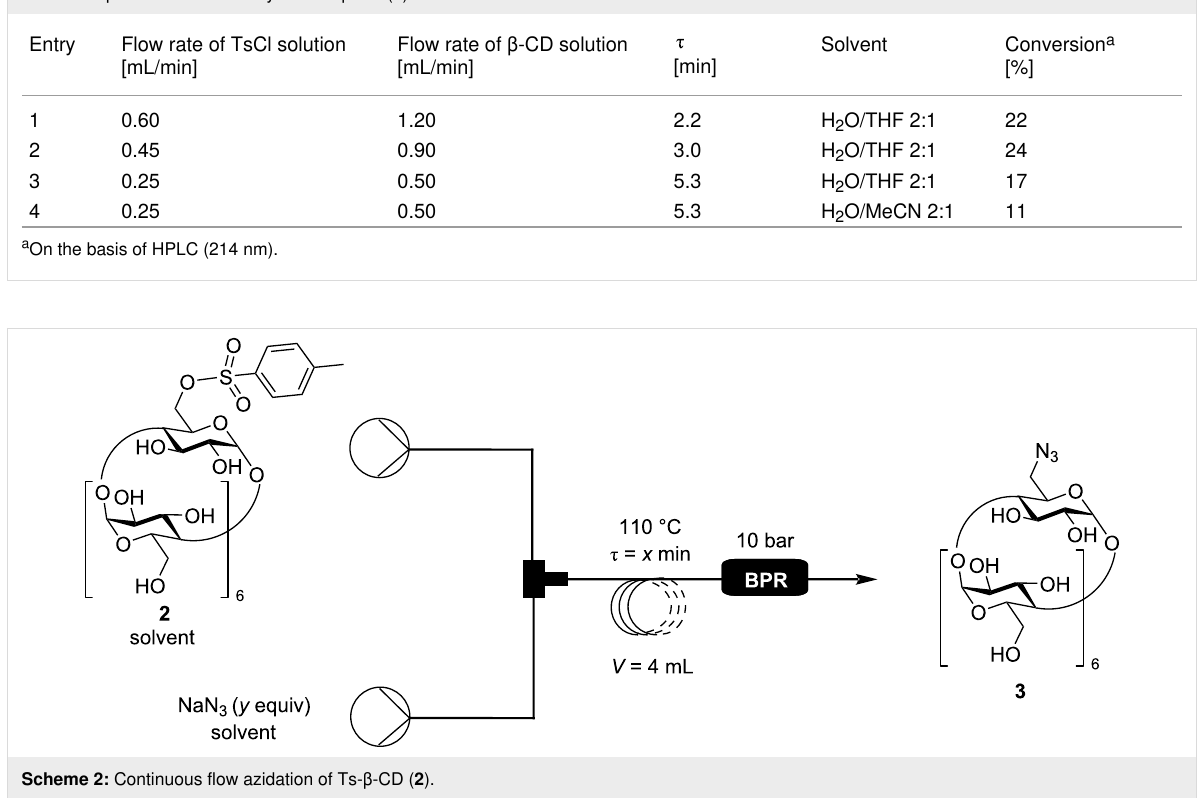
Table 1: Optimization of the tosylation of β -CD ( 1 ) under continuous flow